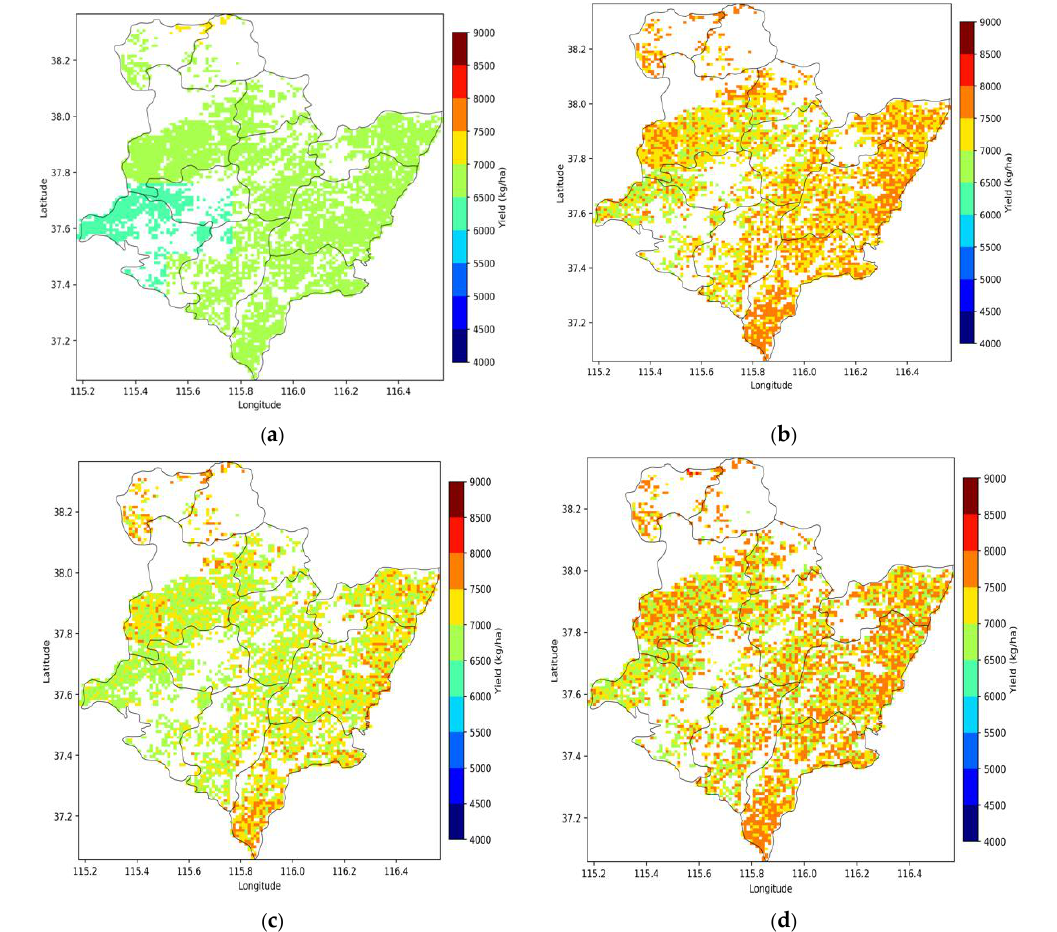
Figure 7. The winter wheat yield simulation with different data assimilation schemes (( a) open-loop; ( b) DA with LAI; ( c) DA with SM; and ( d) DA with SM+LAI). ( a ) Open-loop, ( b ) DA with LAI, ( c ) DA with SM, ( d )DA with LAI+SM.